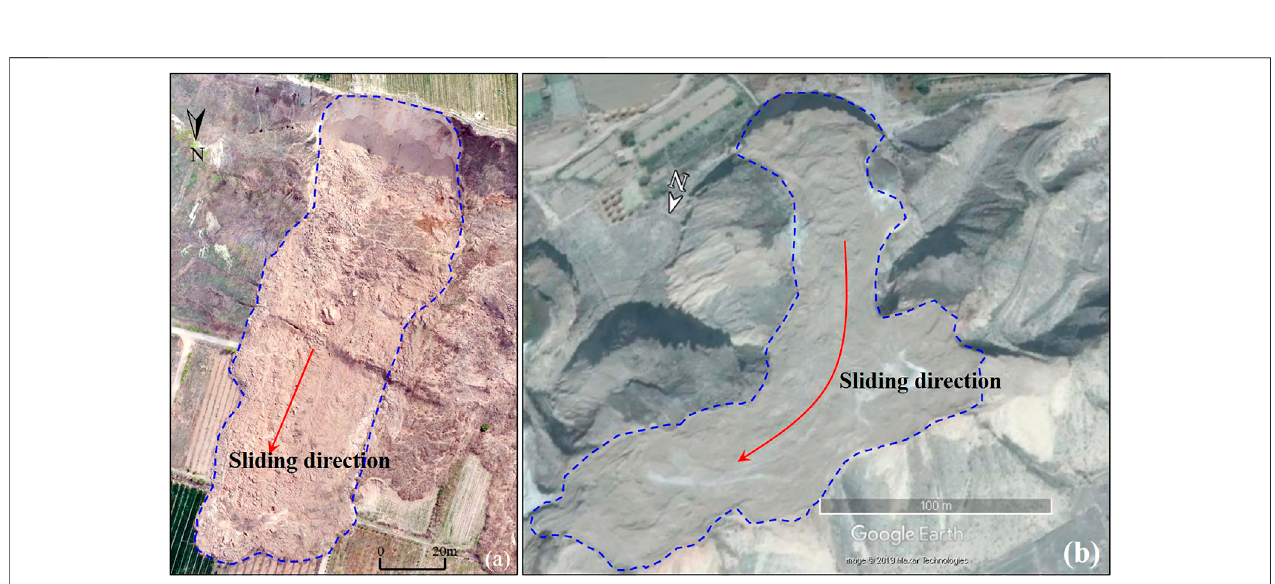
water content sensors were arranged for the tests. The water content sensors were model-5TE produced by the American Decagon Company ( Figure 3 ). The pore pressure sensors were